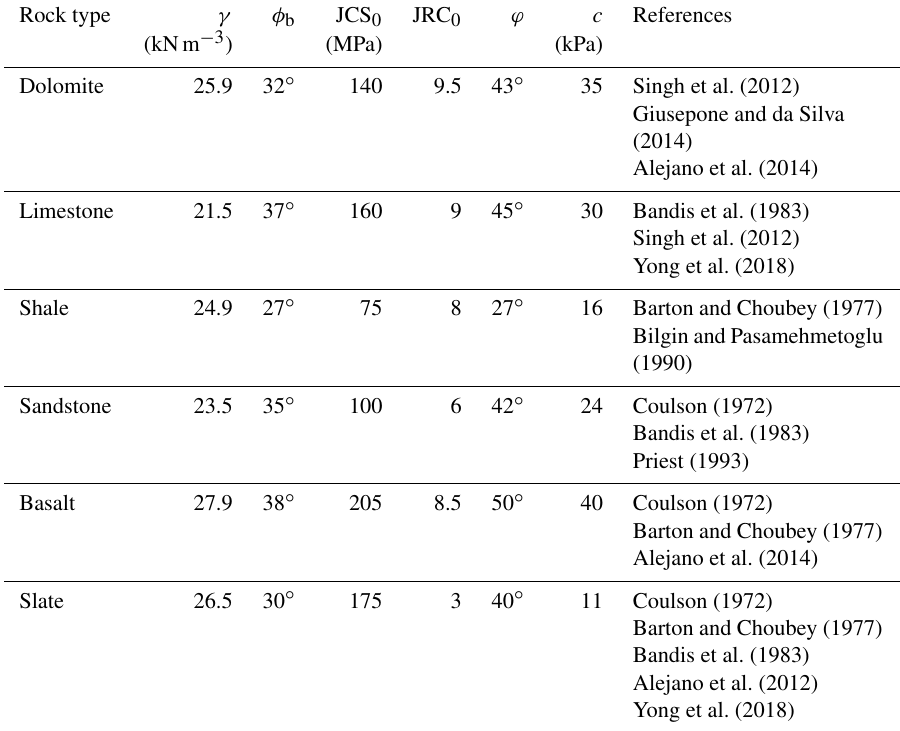
Table 1. Shear strengths assigned to rock types in the study area.